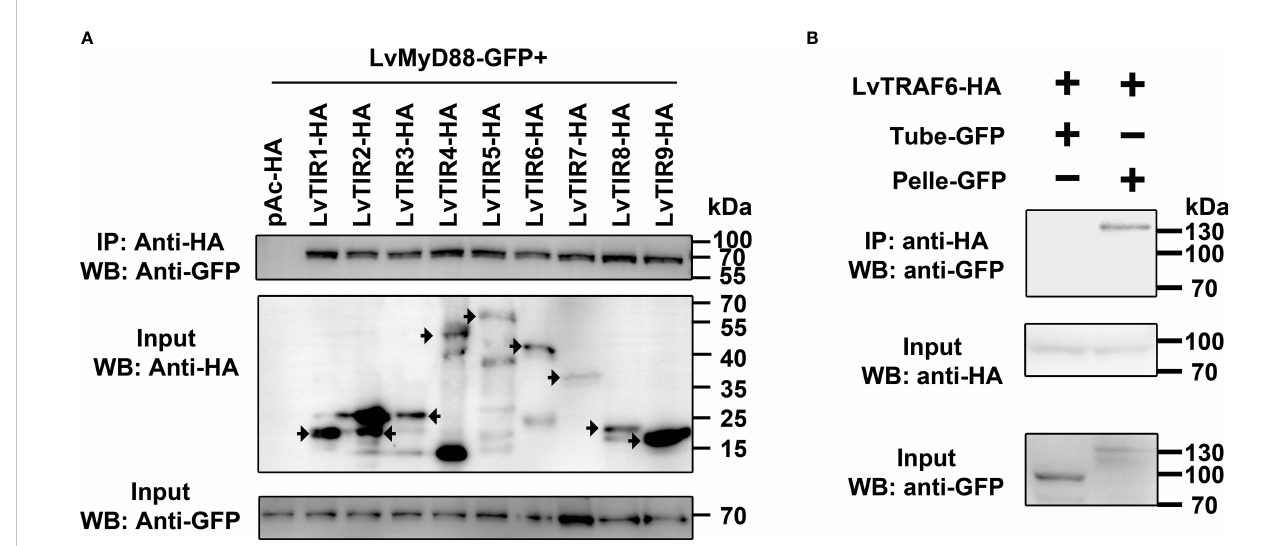
FIGURE 2 LvTolls interacted with LvMyD88 and conferred the signal via Tube-Pelle-TRAF6 cascade. (A) Co-IP assay showed that the TIR domain of all LvTolls interacted with LvMyD88. The black arrow stands for the band that the corresponds to the full length TIR domain. (B) Co-IP assay showed that LvTRAF6 could be co-precipitated by LvPelle but not